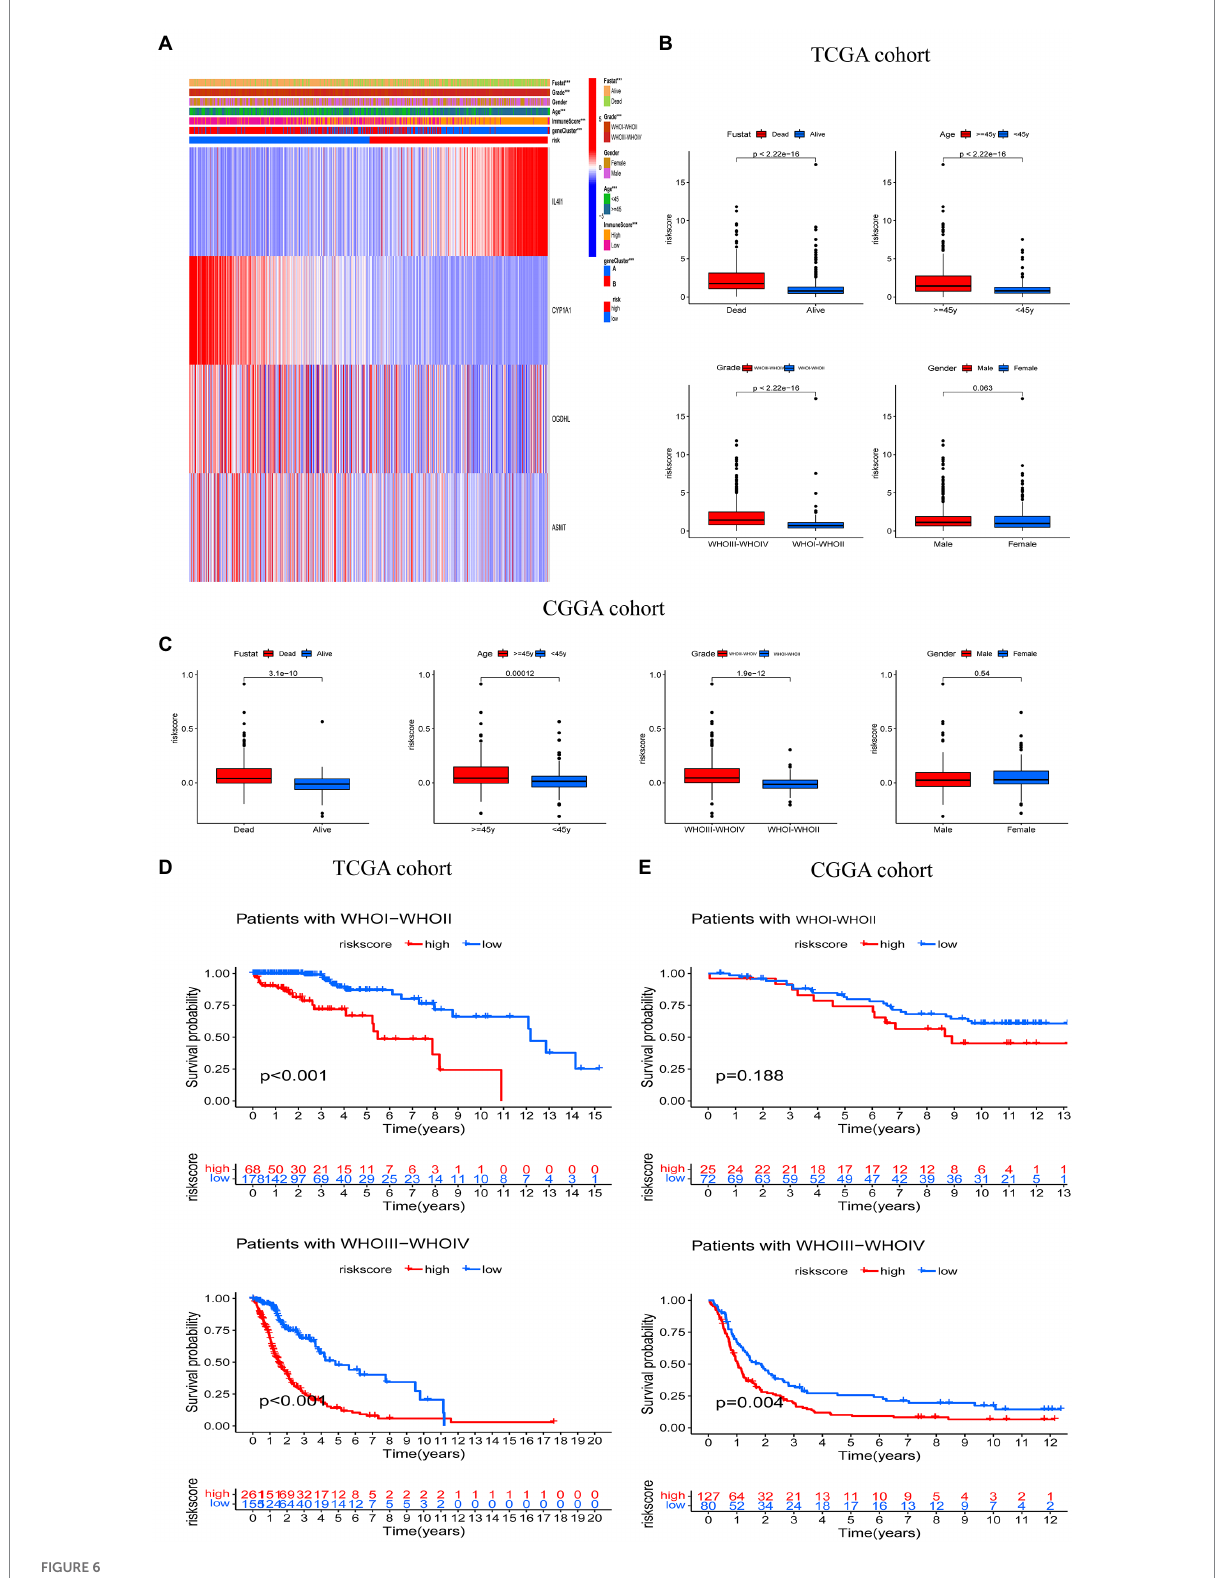
FIGURE 6 Correlation between risk score and clinical characteristics. (A) Relationship between clinicopathologic features and risk score. (B,C) Comparisons of overall survival (OS), WHO tumor stage, age, and gender between the two risk score groups in TCGA and CGGA cohorts. (D,E) Kaplan–Meier analysis of OS between the high and low risk groups in the TCGA and CGGA cohorts according to tumor stage. *** p <